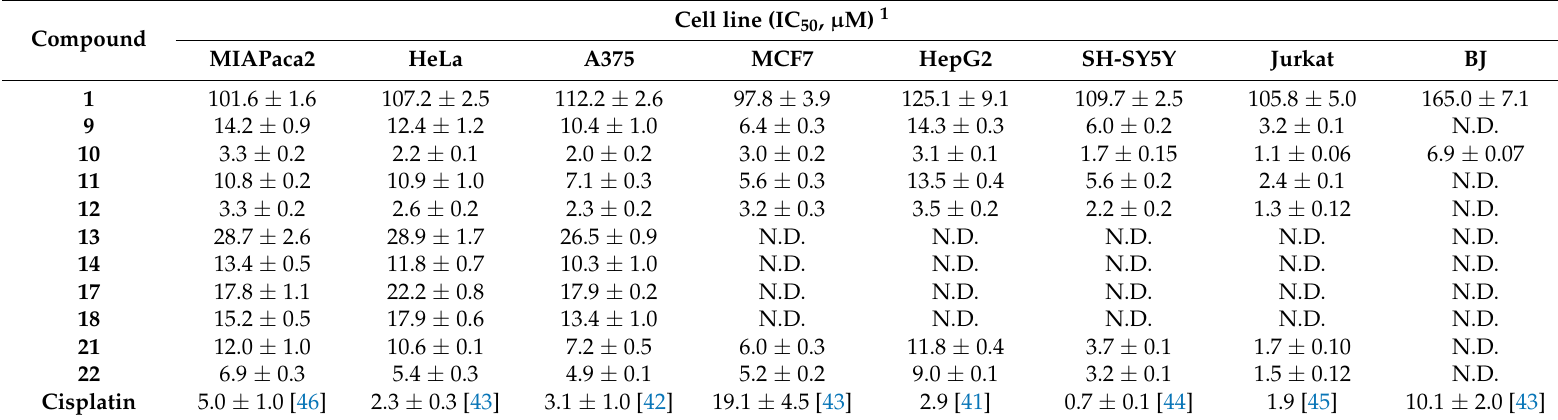
Table 2. Antiproliferative activities of GA, its heterocyclic derivatives, and cisplatin against several cancer cell lines and the nontumoral BJ cell line.